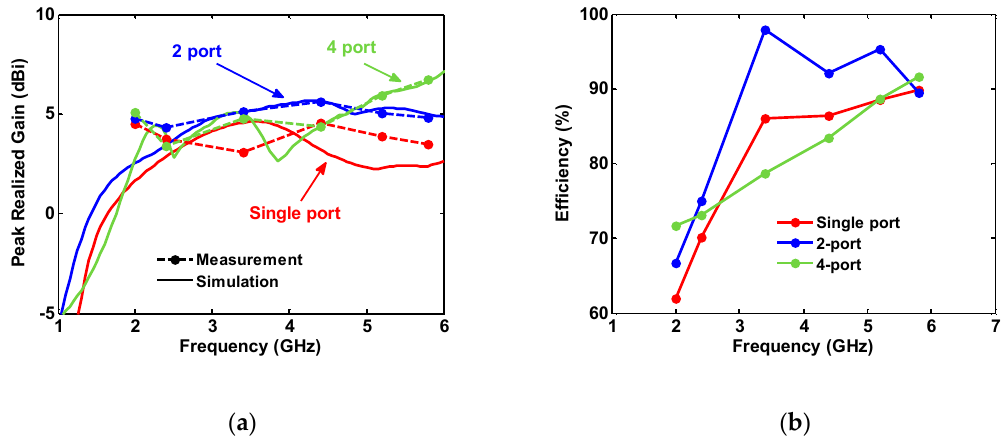
Figure 23. ( a ) Measured and simulated peak gain; and ( b ) measured antenna efficiency